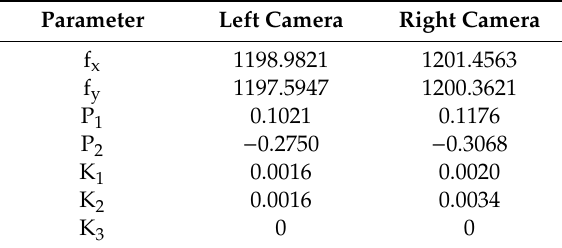
Table 2. Results of camera calibration.